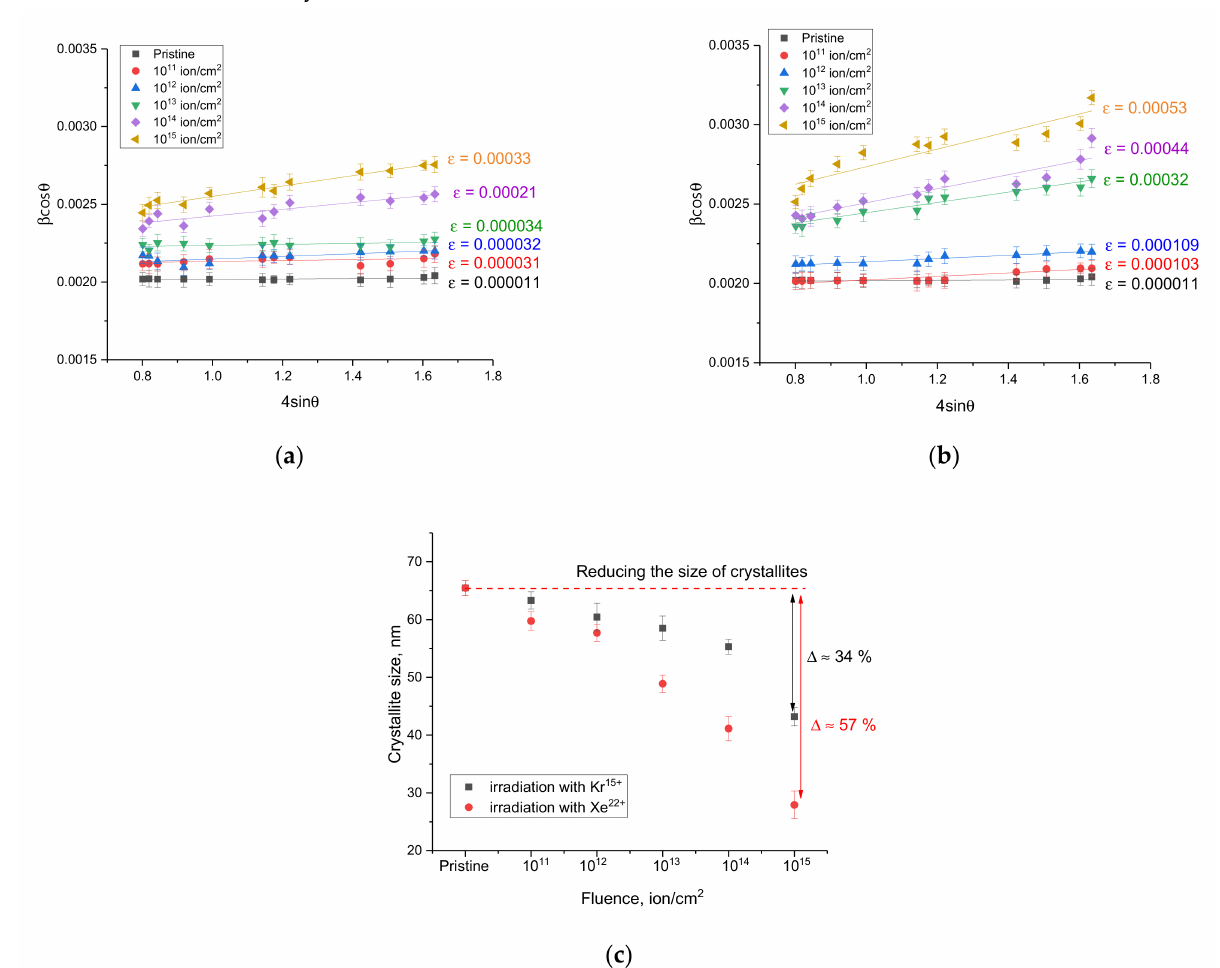
Figure 4. The results of Williamson–Hall plots, reflecting the change in the amount of distortion of diffraction reflections as a result of external influences: ( a ) irradiation with Kr 15+ ions; ( b ) irradiation with Xe 22+ ions; ( c ) The results of the change in the size of crystallites as a result of